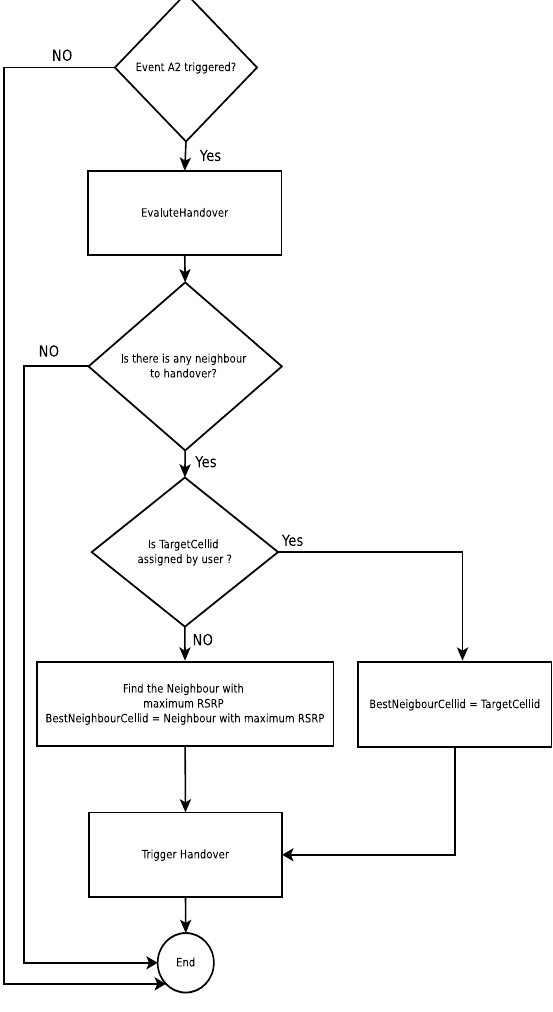
Figure 2: Logic to trigger deterministic